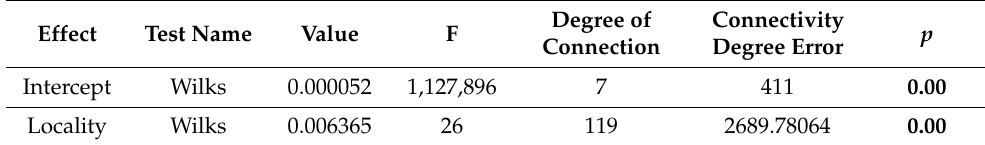
Table 4. Results of ANOVA for eight life traits at 18 localities throughout Zagreb and Medvednica Mt., with five individuals and five leaves per individual of E. annuus. Statistically significant differences are in bold ( p <